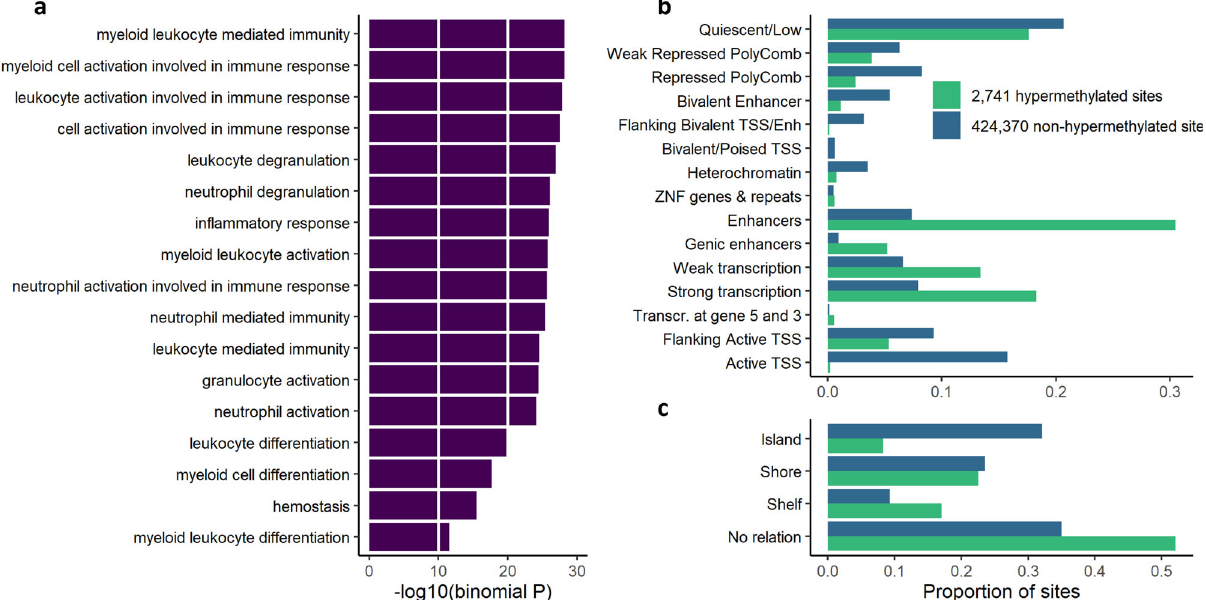
Fig. 2 Characteristics of the 2741 CpG sites hypermethylated in TET2 -mutated CHIP. a Enrichment of Gene Ontology terms for 2741 hypermethylated sites. P values derived using the region-based binomial test in GREAT and are not adjusted for multiple comparisons. b Monocyte chromatin states at hypermethylated and non-hypermethylated sites. c CpG island relations for hypermethylated and non-hypermethylated sites.